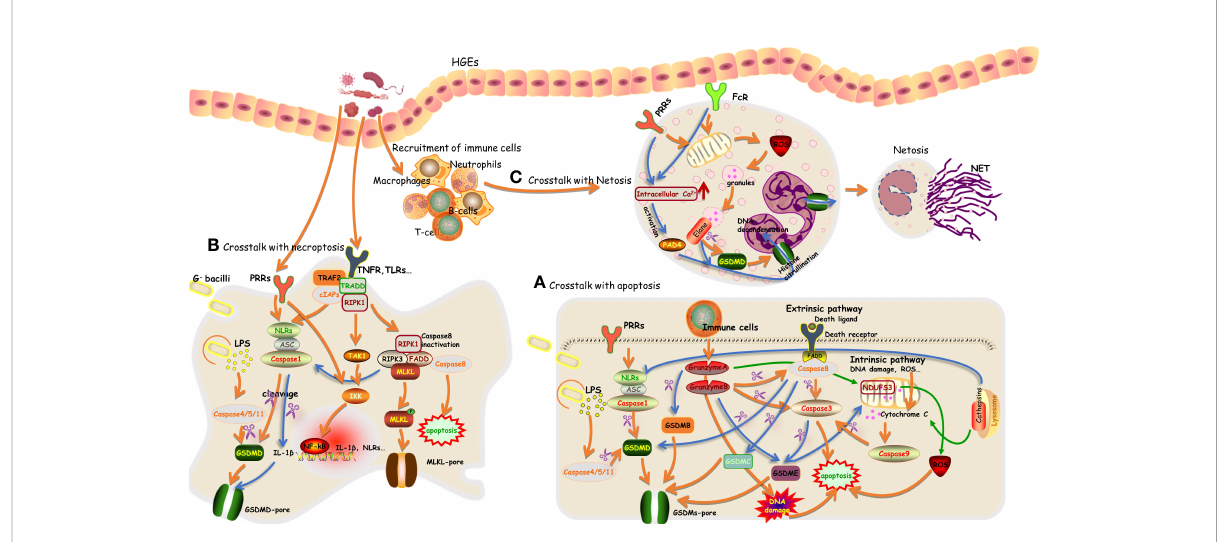
FIGURE 2 An overview of the crosstalk between pyroptosis with apoptosis, necroptosis, and NETosis in periodontal tissue (A – C)